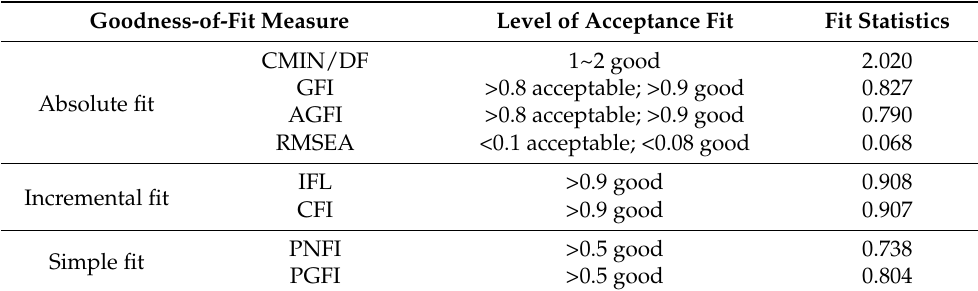
Figure 3. The initial structure model. Table 4. Goodness-of-fit of the structure model.